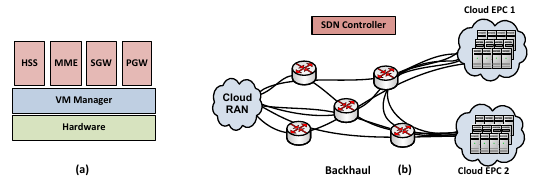
Figure 4. (a) Dedicated hardware running EPC components in the VMs, (b) Traffic steering between the cloud EPCs using SDN controller during VM images moves between the